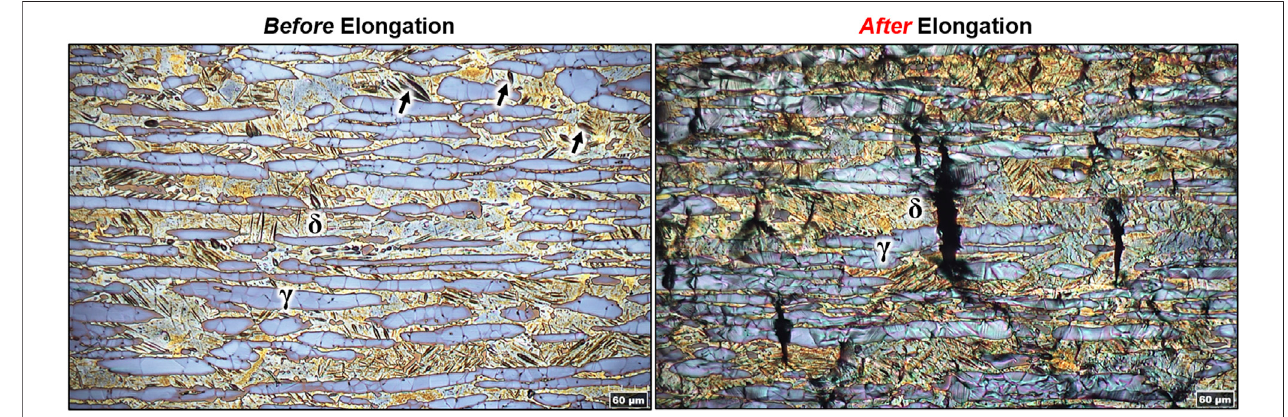
FIGURE 12 | Optical micrographs showing the surface of the tensile specimen that was charged with hydrogen for 10 h with − 38 mA/cm 2 (left) and then strained until catastrophic failure (right) . Note that blister cracks (indicated by the arrows) developed in the ferrite phase (left) after 10 h of hydrogen charging before the elongation experiment. In addition, numerous secondary cracks developed primarily in the ferrite phase after mechanical elongation (right)